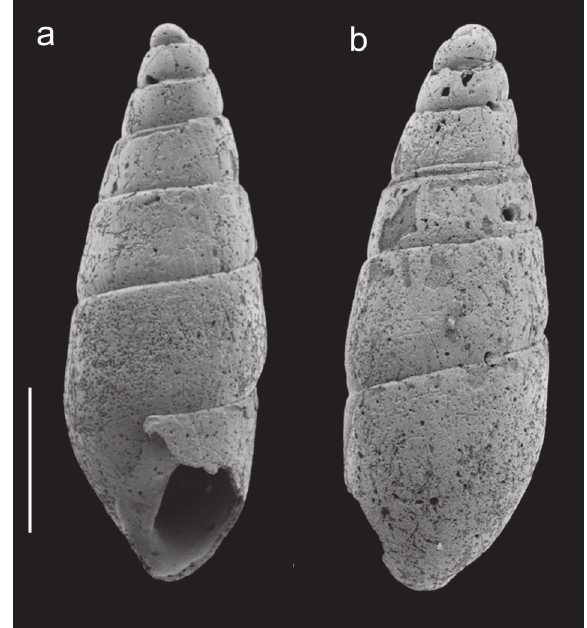
Figure 4. A. Shell of Odostomia fernandina , holotype (USNM 108053) in apertural view; B. same, in adapertural view. Scale bar: 1